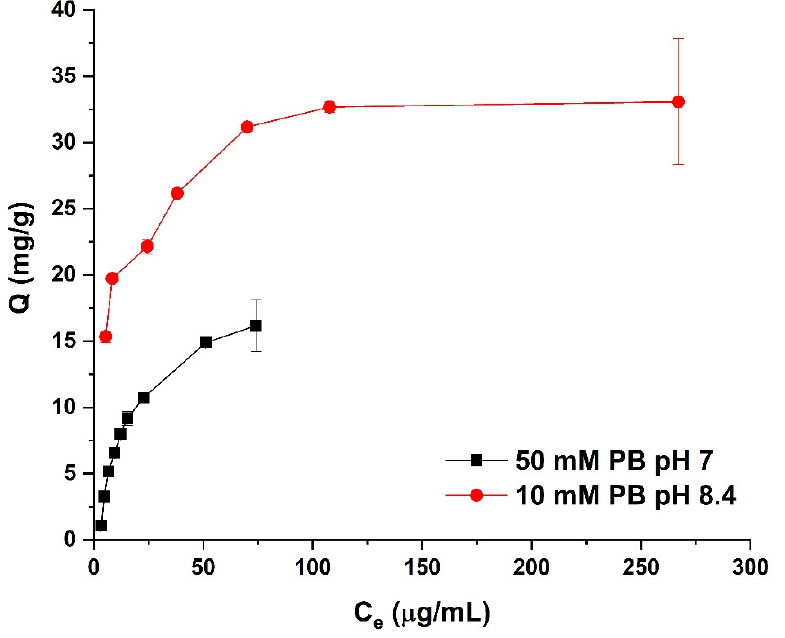
Figure 6. Adsorption isotherms of Lys-PMNPs in buffered solution of lysozyme. (1.6 mg/mL Lys- PMNP was incubated with 5, 15, 30, 40, 60, 80, 120, 160 and 320 µg/mL lysozyme in 10 mM PB pH 8.4, and in 5, 10, 15, 20, 25, 30, 40, 75 and 100 µg/mL lysozyme in 50 mM PB, pH 7 (n = 3)).